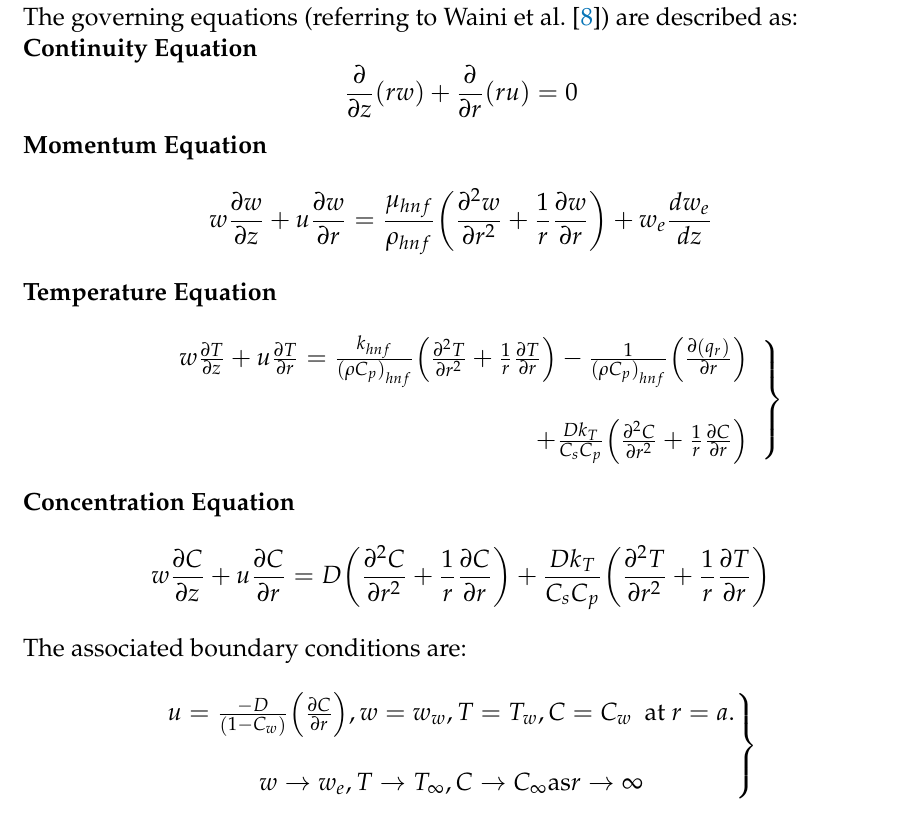
Figure 1. Physical